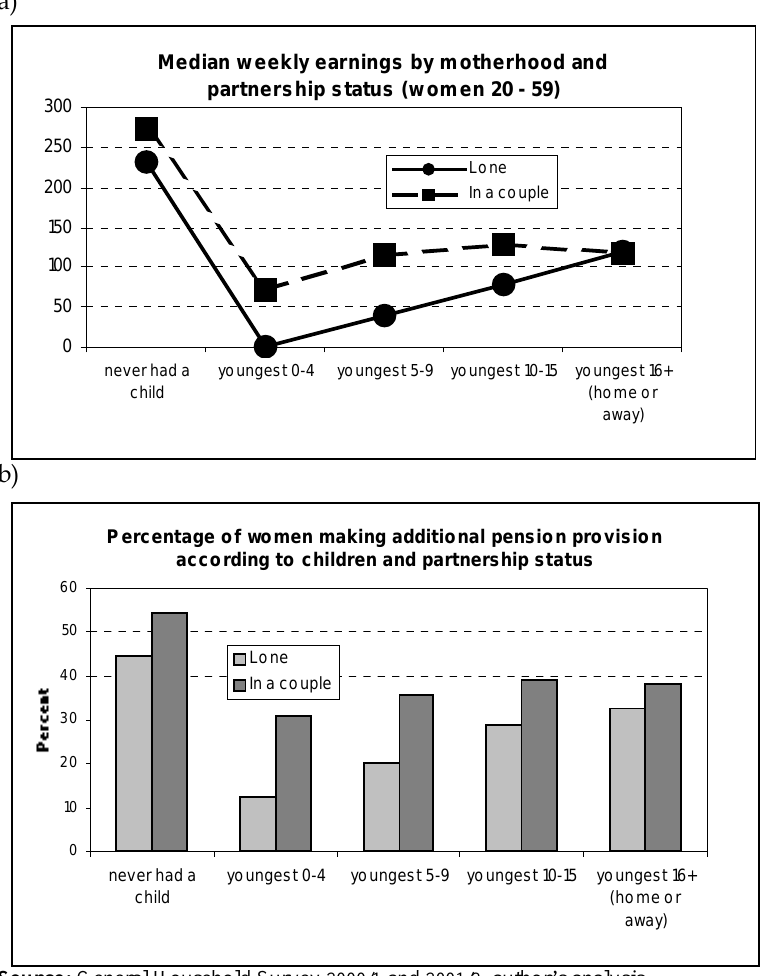
Figure 3. Median weekly earnings and percentage of women making